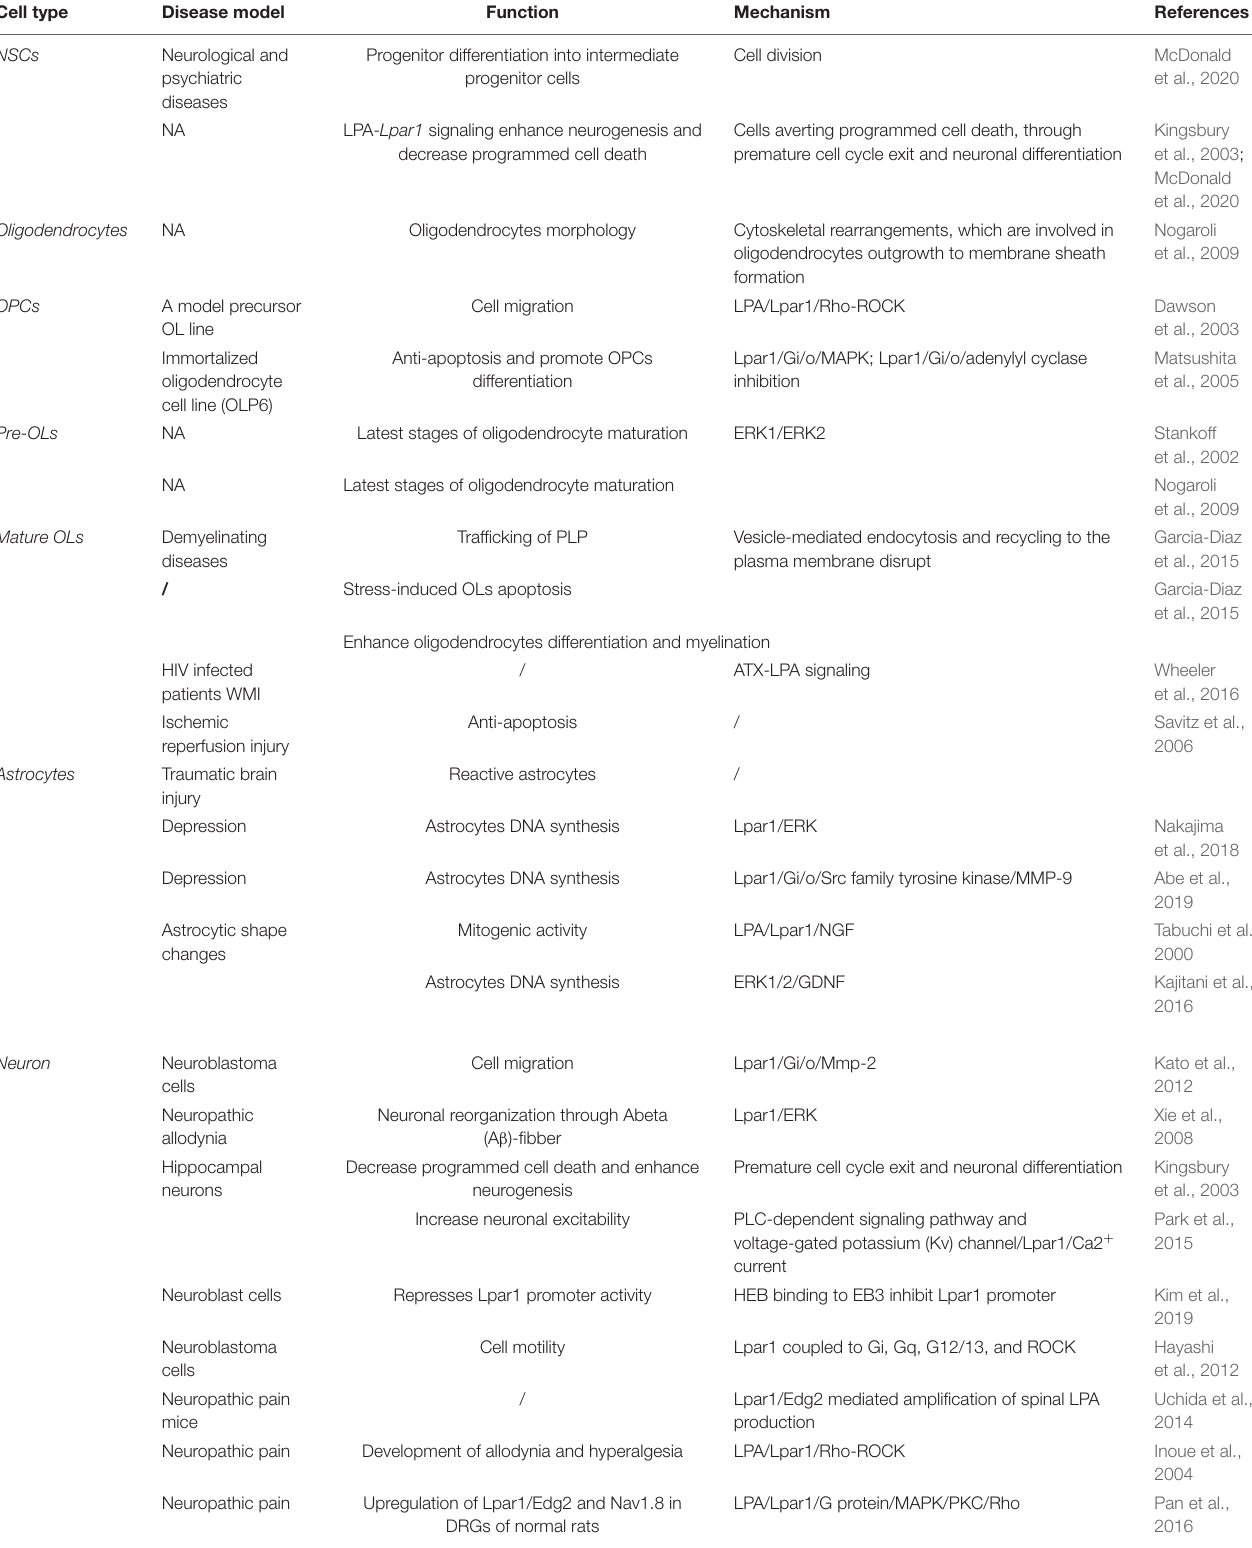
TABLE 1 | The role of Lpar1 in the